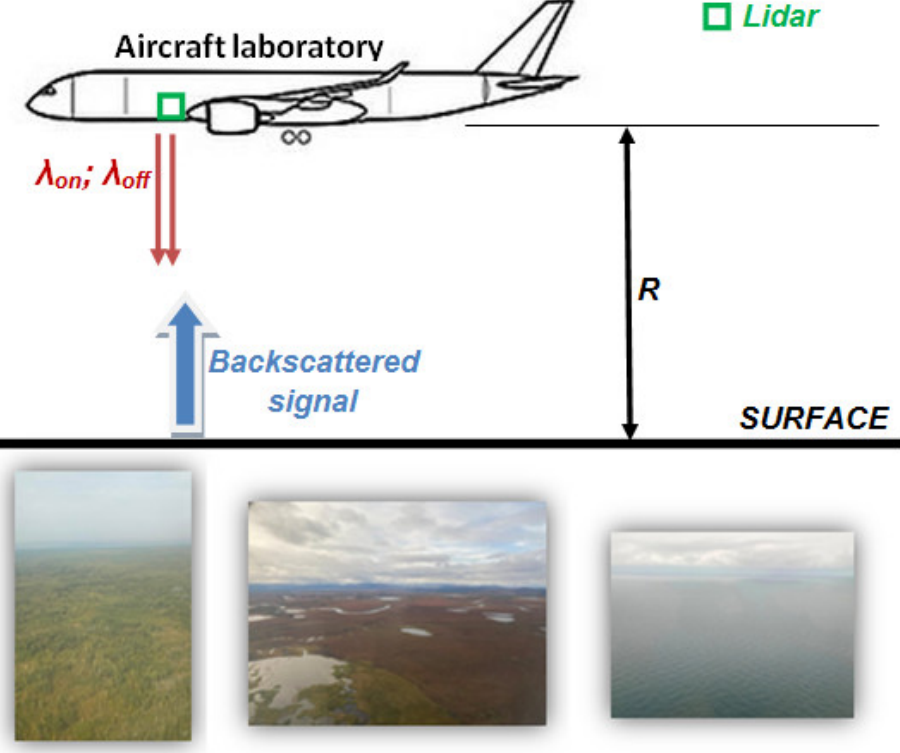
Figure 15 . The lidar monitoring scheme from the aircraft laboratory (λ on ; λ off —informative wave- Figure 15. The lidar monitoring scheme from the aircraft laboratory ( λ on ; λ off —informative wave- lengths of methane monitoring; R—monitoring path (range)). lengths of methane monitoring; R—monitoring path